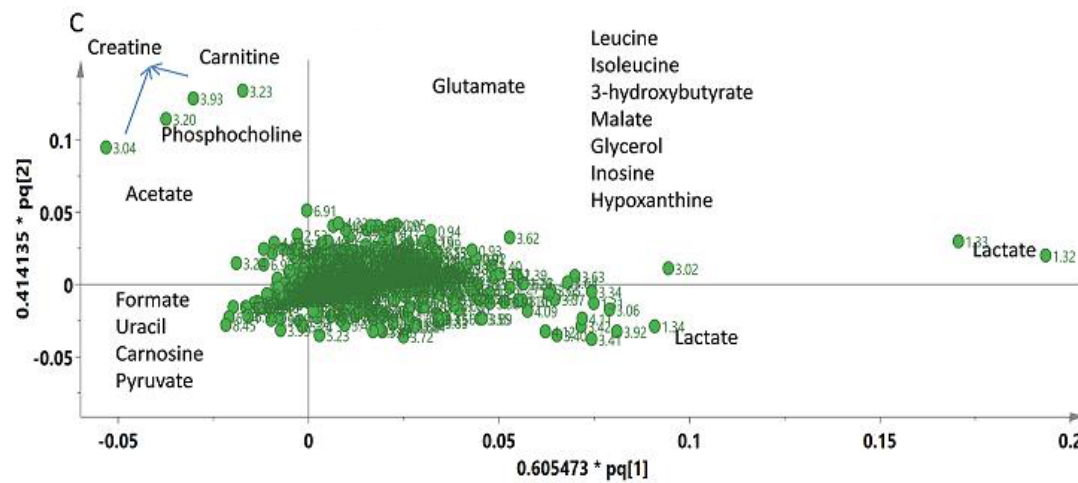
Figure 4. ( A ) Score plot (PLS1 vs. PLS2) of OPLS-DA based on whole range of 1 H-NMR signals ( δ 0.5– δ 10.0) of MS = Chevon; BM = Beef; DM = Donkey. ( B ) Validation through 200 permutation test. ( C ) Loading scatter plot of OPLS-DA.